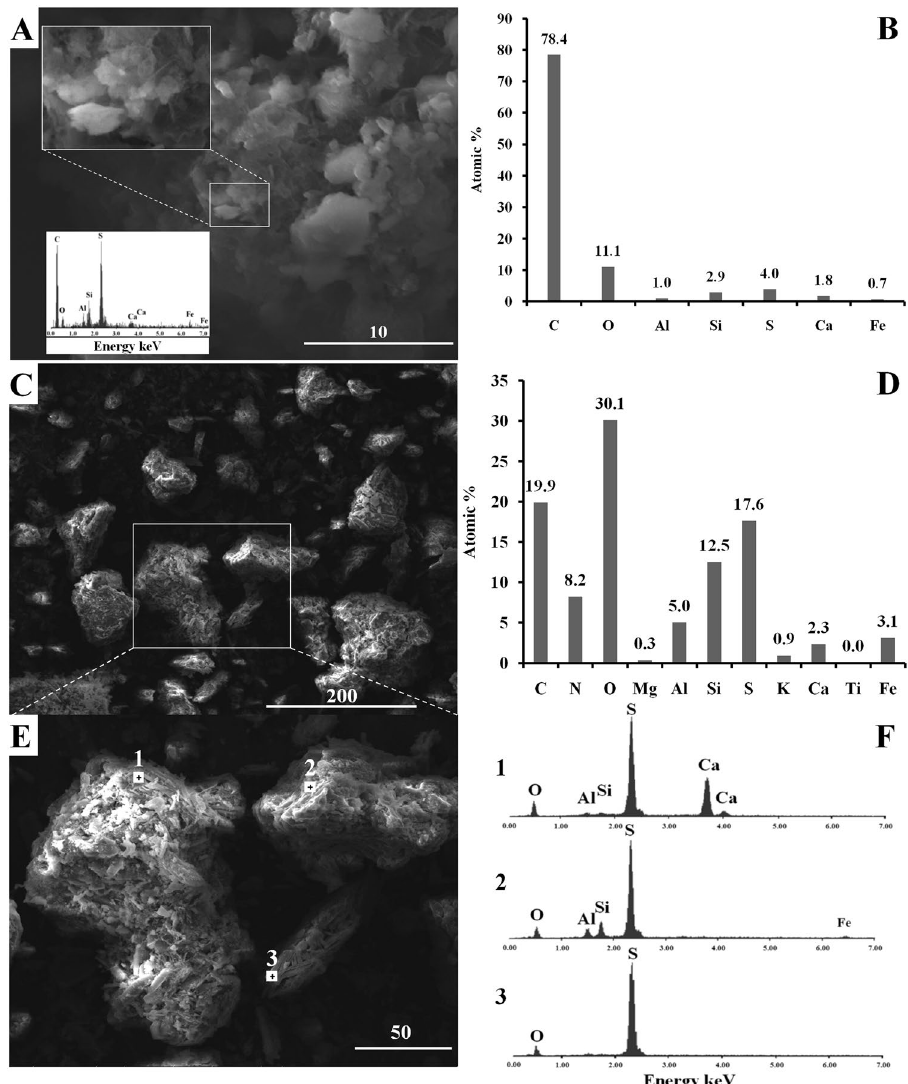
Figure 2. Characteristics of the chemical composition of the samples. Scanning electron micrographs of samples AL3T ( A ), and AL3crust ( C ), with the corresponding average atomic percentage of the prominent elements ( B and D , respectively) calculated from EDS microprobes. An insert on panel A shows EDS spectrum of the S-enriched area, presumably amorphous sulphur. Panel E is an S-enriched area in AL3crust sample containing gypsum crystals (1), amorphous sulphur (2) and crystalline sulphur (3) in the locations 1, 2, and 3, respectively. Panel F shows the corresponding EDS spectra. Scale bars in the SEM images are in μ